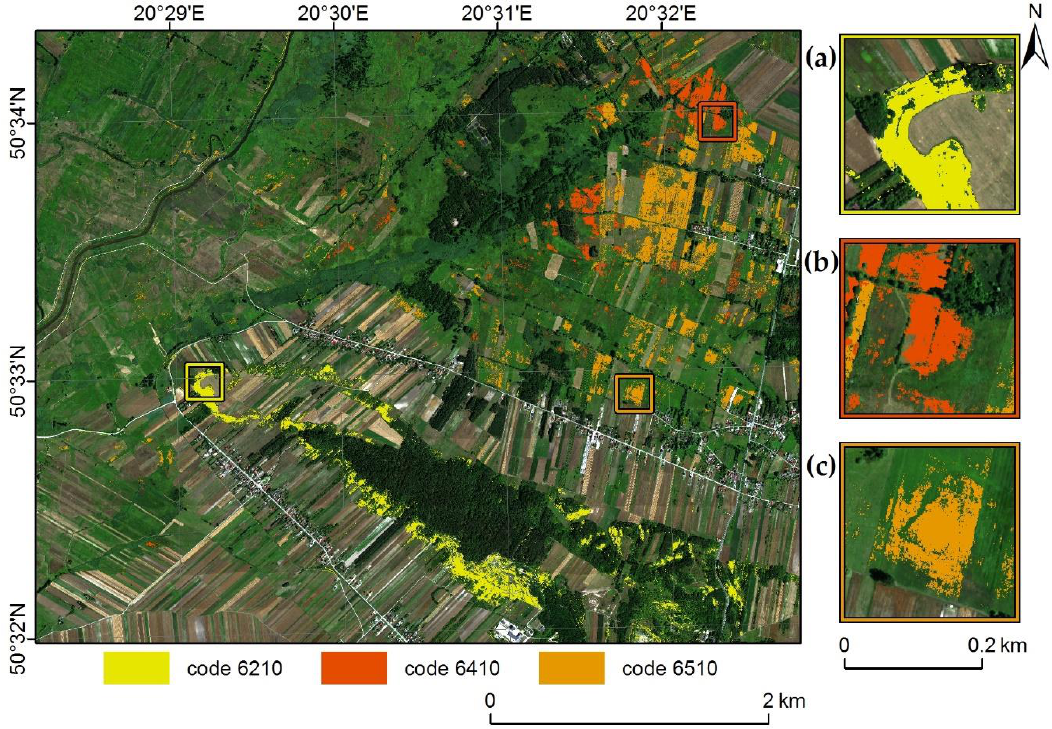
Figure 5 . Distribution of all classified habitats based on the classification with the highest average F1 = 78.9% (C1_C2_C3_MNF + TOPO) (codes: 6210 ( a ); code 6410 ( b ) and code 6510 ( c ); basemap: HySpex image in natural red, green, blue (RGB) composition, acquired in July 2017). Table 6. Errors and accuracy of C1_C2_C3_MNF + TOPO class dataset (the highest mean of F1 values for all habitats).